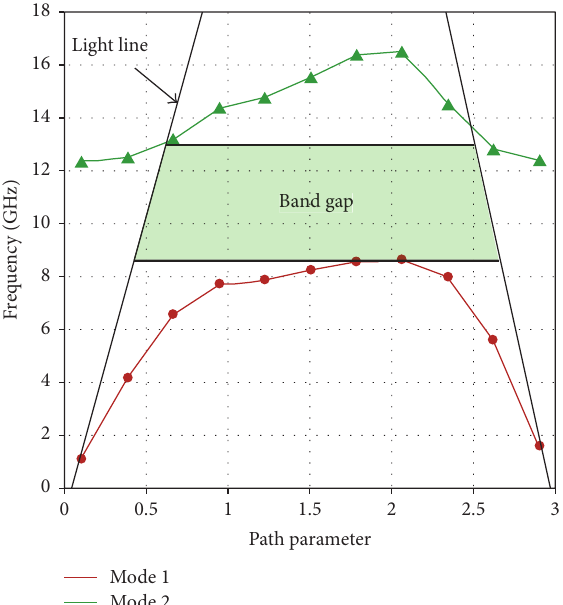
Figure 2: Dispersion diagram.